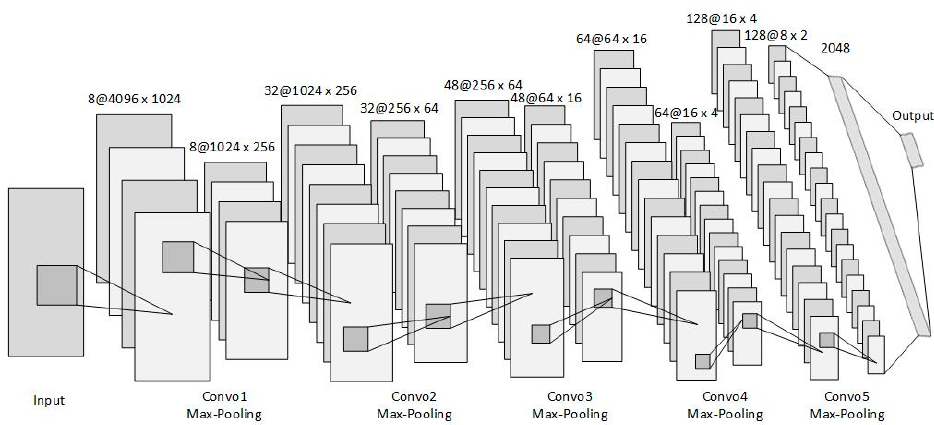
Figure 4. Schematic diagram of DCNN structure. After five convolutional pooling of the input data, the final output is generated through a fully connected layer.